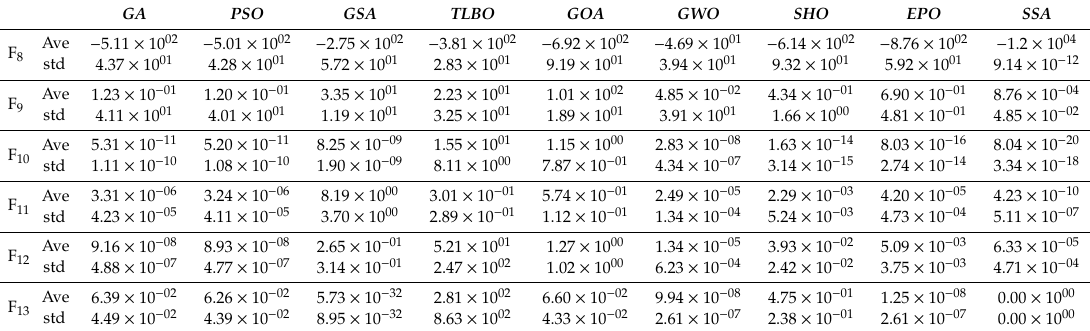
Table 2. Results for SSA and other algorithms in Multimodal test functions.